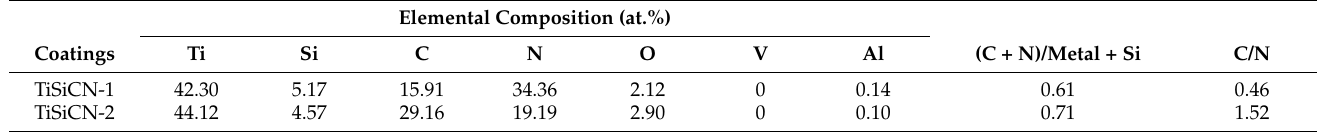
Table 1. Elemental composition determined by EDS for TiSiCN-1 and TiSiCN-2 coatings. Elemental Composition (at.%)